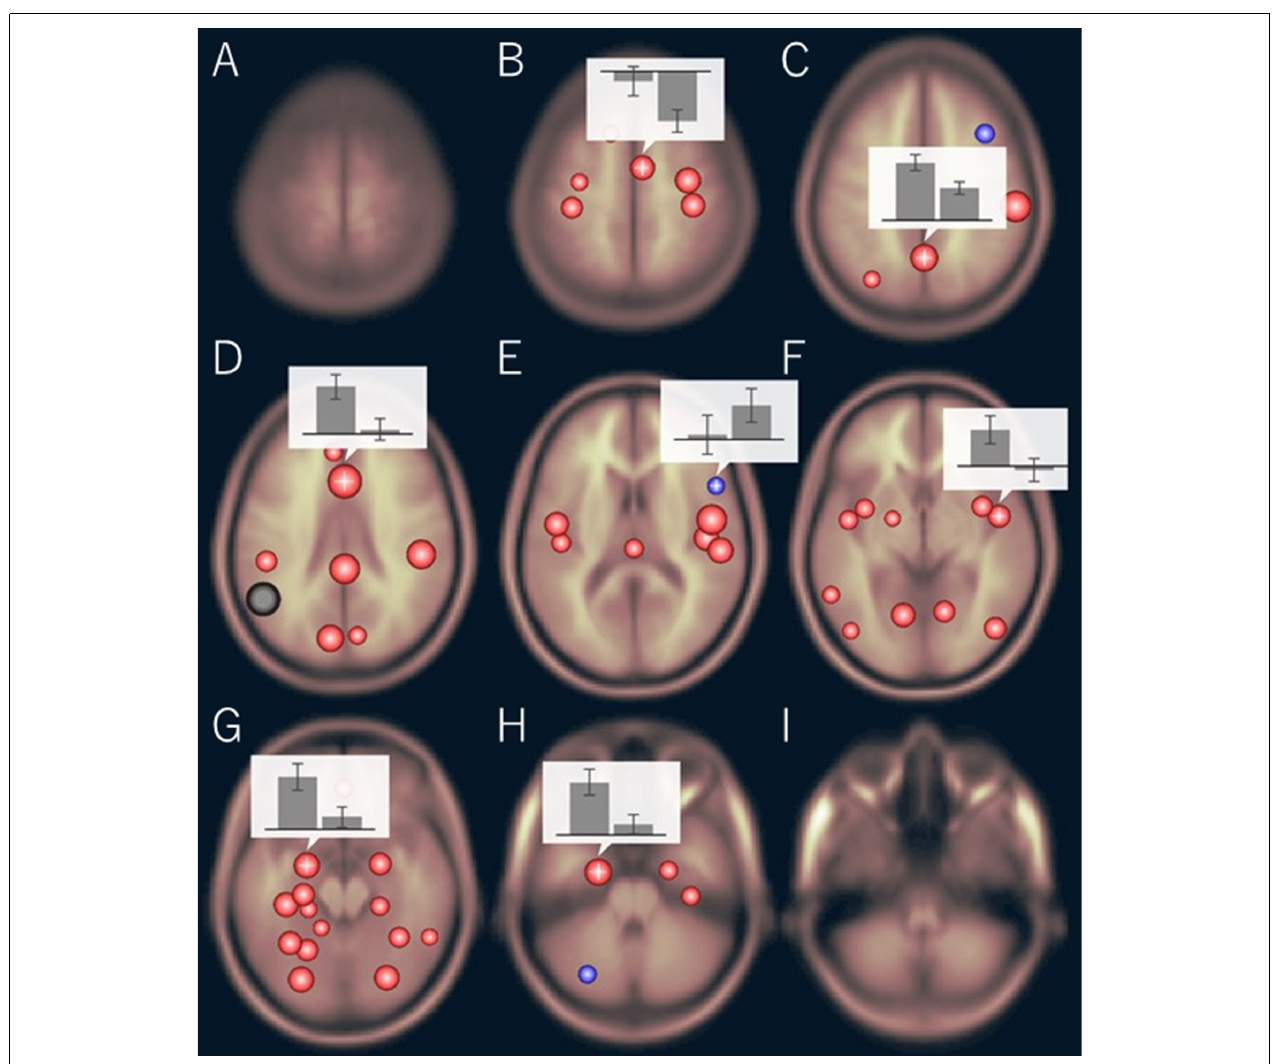
FIGURE 3 | Region of interest (ROI)-to-ROI functional connectivity of the left AG as the seed during imagined music performance vs. resting condition. The bar graphs show the strength of the functional connectivity (left: performance, right: resting). (B) Right supplementary motor area (SMA), (C) precuneus, (D) anterior cingulate cortex (ACC), (E) right inferior frontal gyrus (IFG), (F) right planum polare, (G) left amygdala, (H) left anterior parahippocampal cortex. The significance level was p < 0.05, false discovery rate